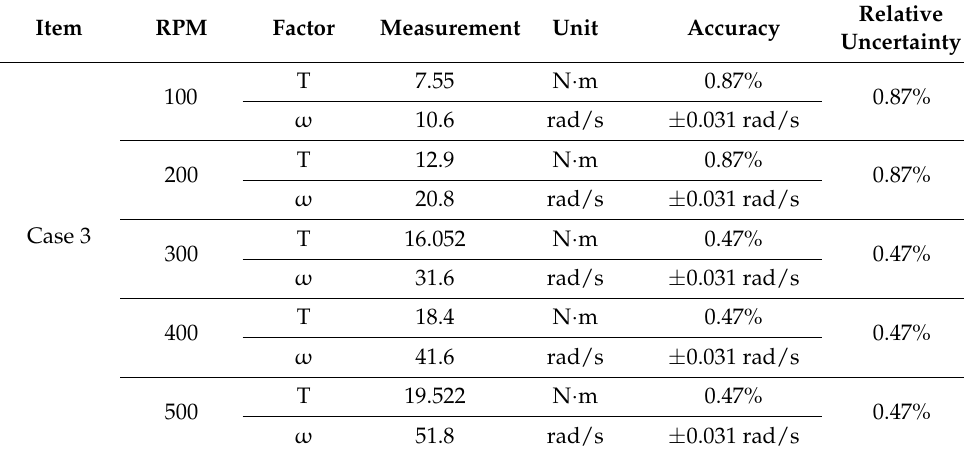
Table 6. Relative uncertainty of case 3 in terms of output energy.